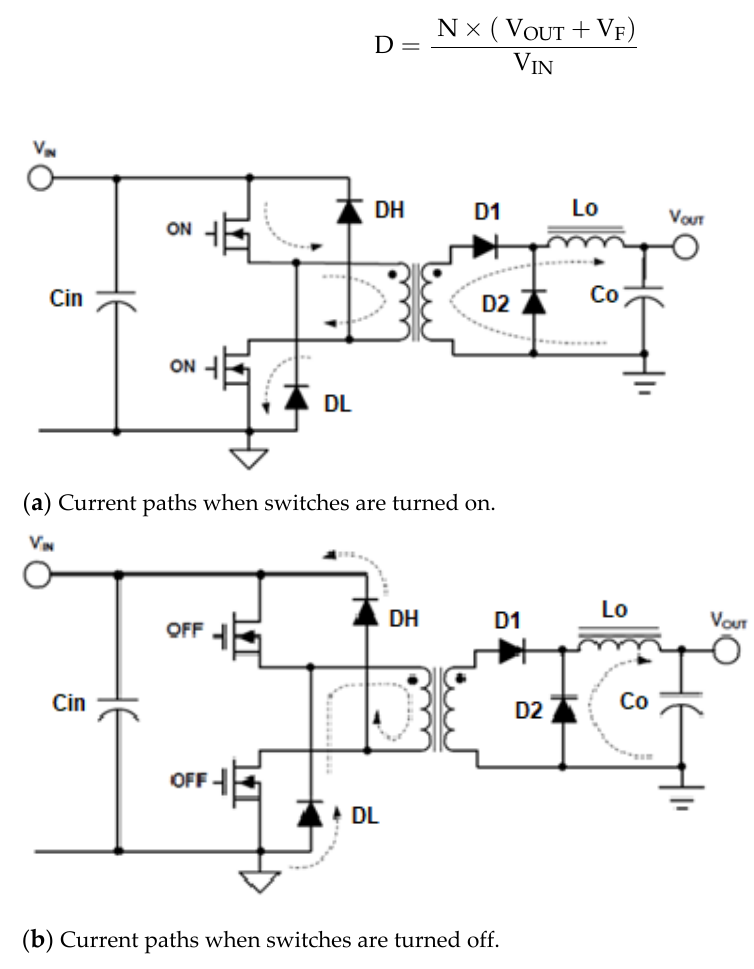
Figure 11. Operating modes of Dual-Switch Forward converter.